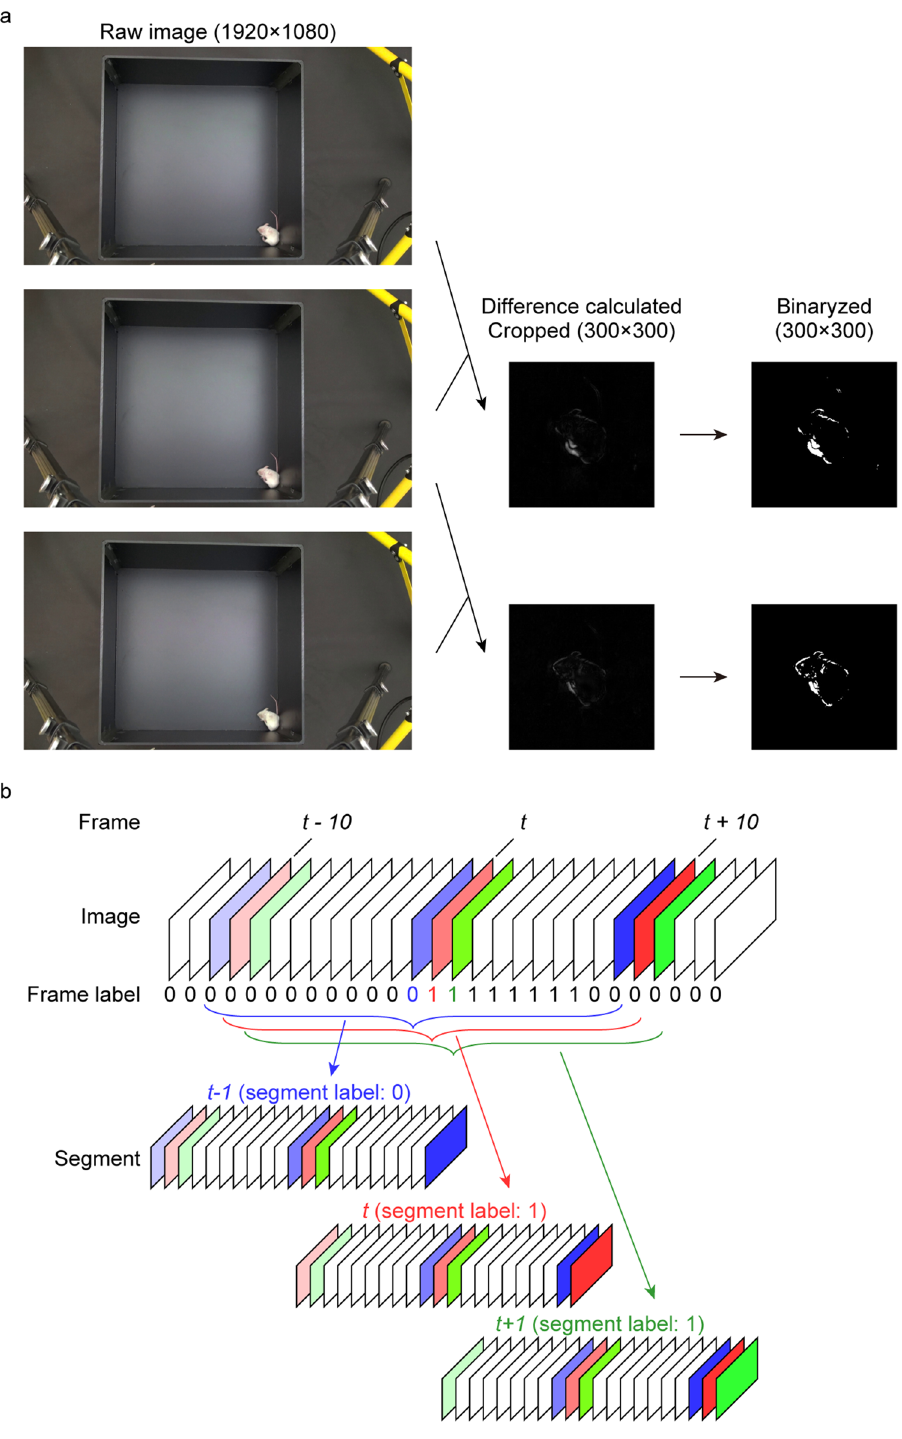
Figure 1. Image pre-processing and integration. ( a ) Video file was divided into the images of each frame. The absolute difference of each pixel between two continuous frames was calculated and cropped in a square shape (300 × 300 pixel) around the geometric centre of mouse. Images were then grey-scaled and binarized. ( b ) For segment at time t , the pre-processed images from t − 10 to t + 10 was collected and labelled with the value of frame label at time t . The figure shows segment at t − 1 (including images from t − 11 to t + 9, labelled as “0”), segment at t (including images from t − 10 to t + 10, labelled as “1”), and segment at t + 1 (including images from t − 9 to t + 11, labelled as